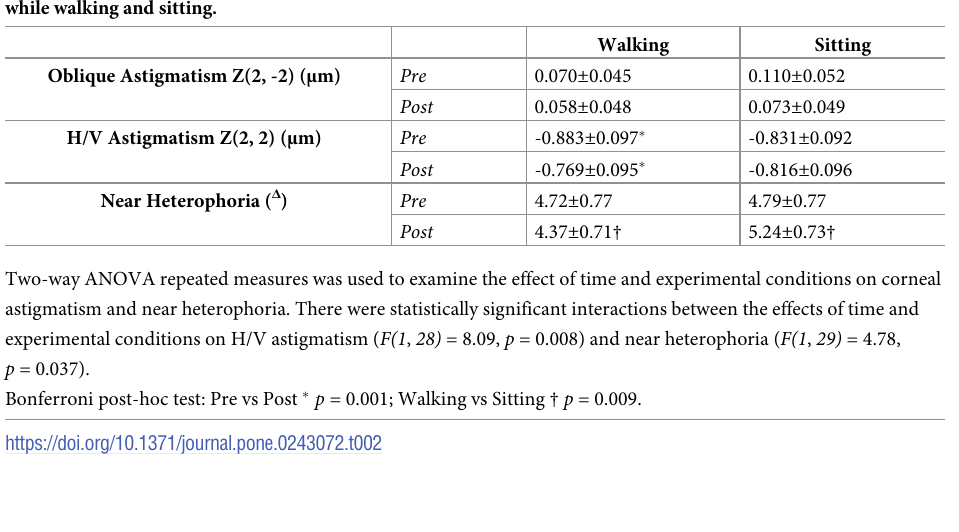
Table 2. Summary of changes in corneal astigmatism and near heterophoria after 30-minute smartphone use while walking and sitting.